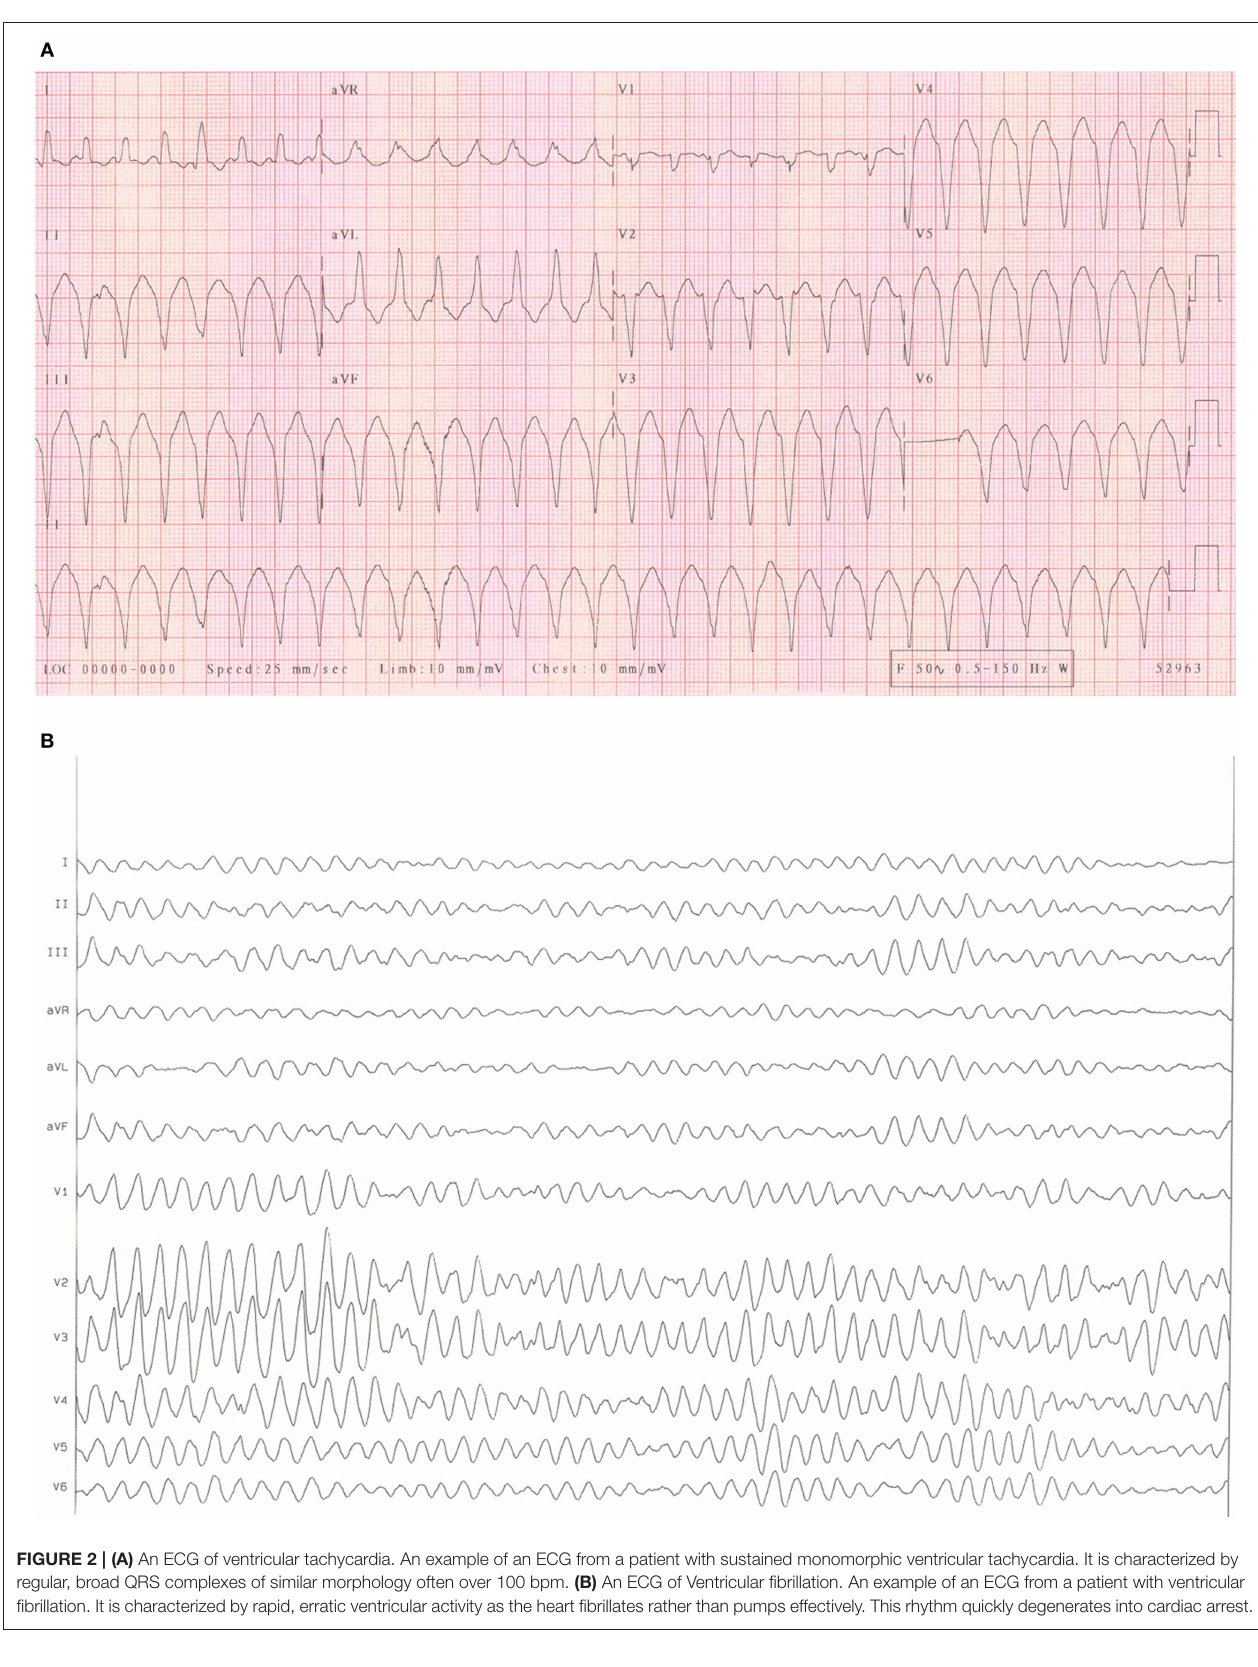
Frontiers in Medicine | www.frontiersin.org